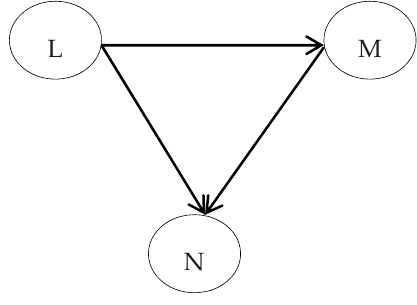
Figure 4. A simple Bayesian Network structure.